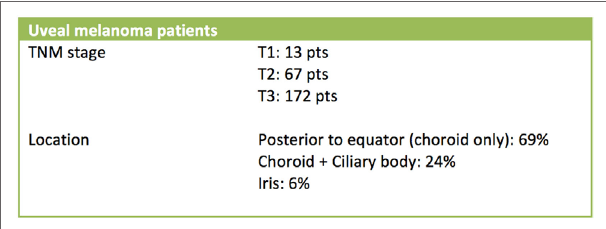
FIgURe 9 | Stage and location distribution (uveal melamona).